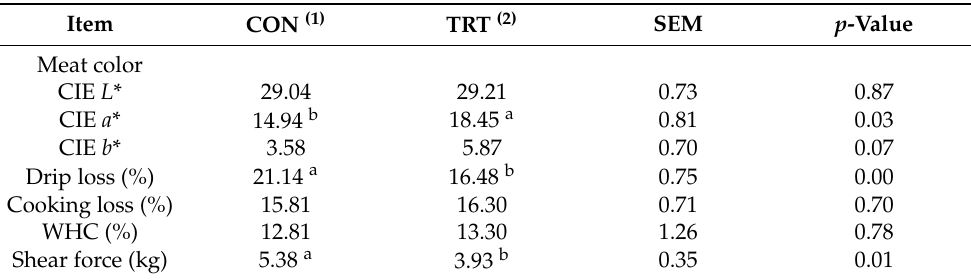
Table 5. Effect of stevioside and organic selenium on meat quality of Longissimus dorsi muscle from